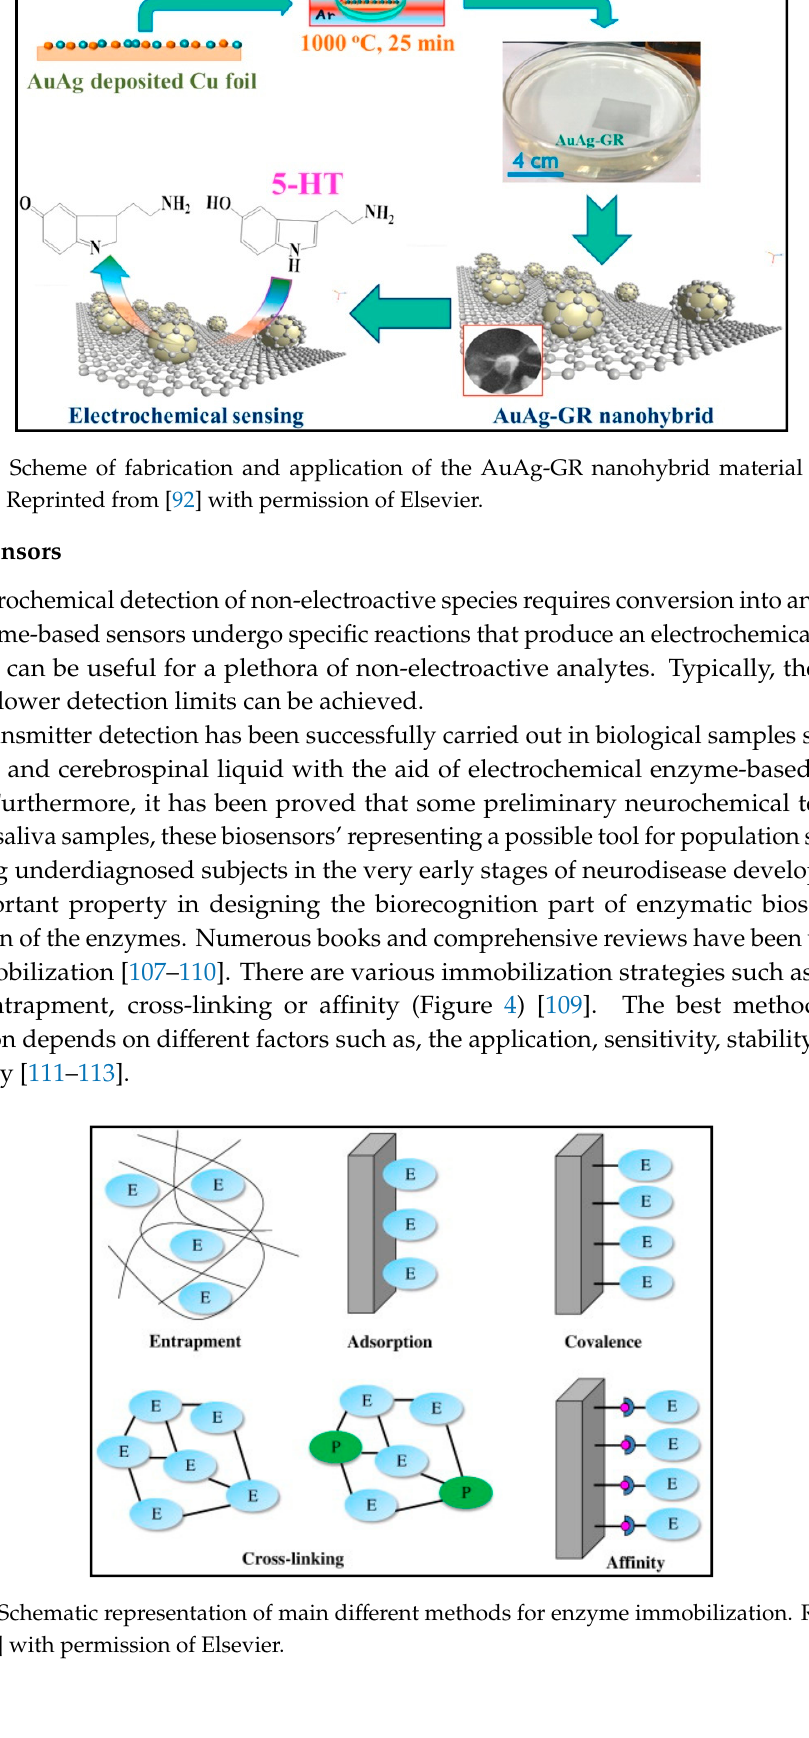
Figure 3. Scheme of fabrication and application of the AuAg-GR nanohybrid material for 5-HT detection. Reprinted from [92] with permission of Elsevier.